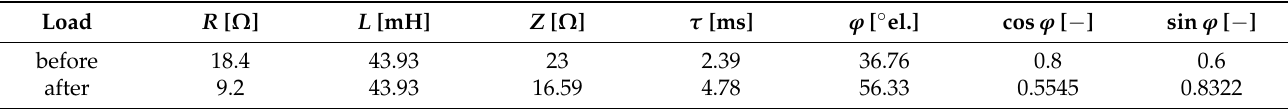
Table 29. Load parameters for steady states before and after load change.